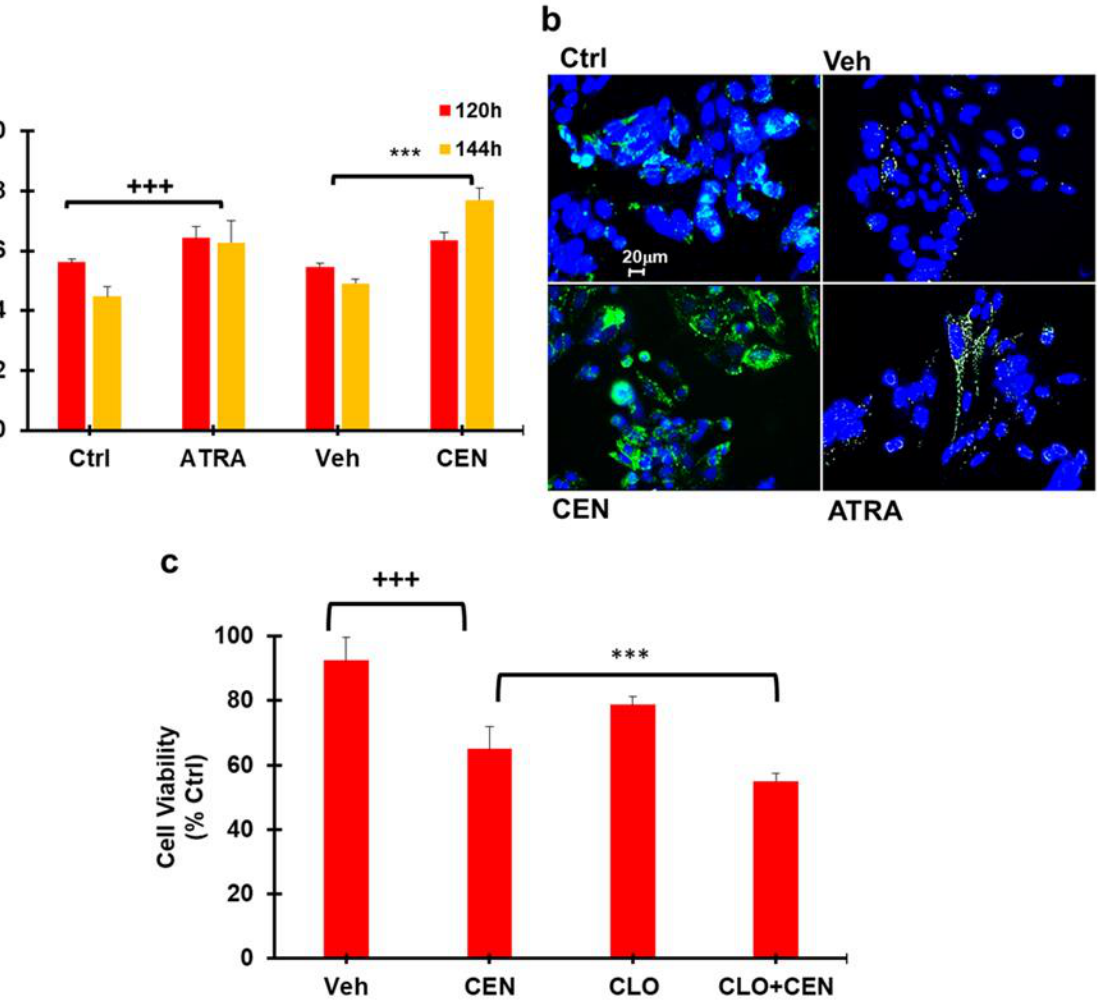
Figure 3. CEN induces protective autophagy in SAOS400 cell lines. Panel ( a ): SAOS400 cells were treated for the indicated time with CEN (200 μg /mL) or ATRA (2 μ M) used as a positive control. Cyto-ID staining was used to quantify intracellular autophagosomes and expressed as FITC/DAPI fluorescence, as described in the Methods Section. Panel ( b ): Micrographs of the representative fields of SAOS400 cells treated as described in ( a ) (400× magnification). Panel ( c ): Cells were treated with CEN (200 μ g/mL) or pretreated with chloroquine (CLO; 10 μ M) before incubation with CEN for 96 h. The Cristal Violet assay was used to assess cell viability at the end of incubation, as de- scribed. The bar graphs represent the mean ± SD, and symbols and linear bars indicate significance: *** p < 0.001 of SAOS400 vs. CLO and CEN mono treatments; +++ p < 0.001 CEN vs. cells treated with control nanoemulsions (Veh).